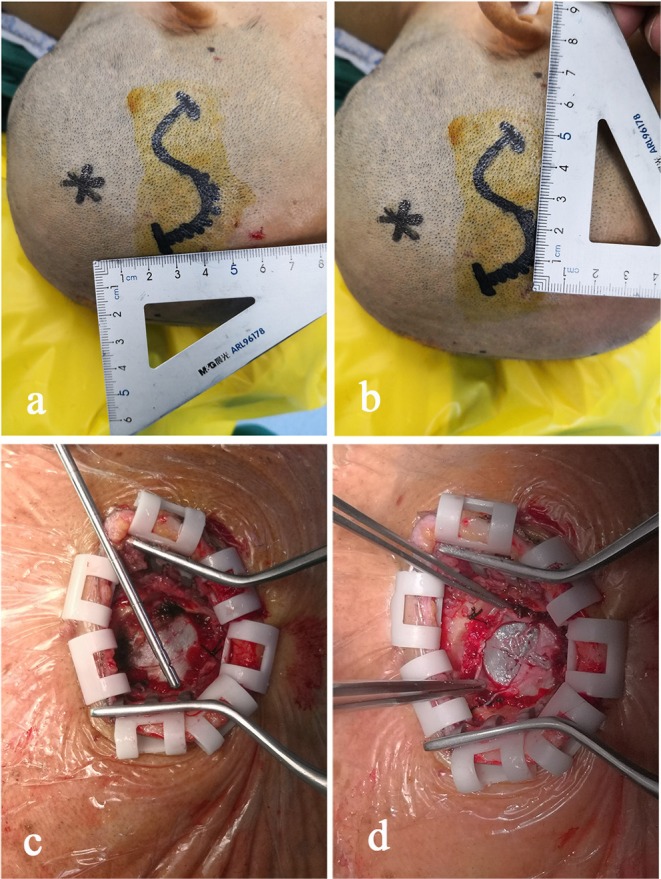
The midpoint of the surgical incision is generally 3–4 cm in front of the apical nodule. The direction of the incision is parallel to the scalp vessel, and the incision is in an “S” shape with a length of 4–5 cm (a,b). After a hole is drilled in the skull, a small bone flap with a diameter of 2.0–3.0 cm is cut using a milling cutter (c). The wall envelop of the hematoma sac can be seen using a cross-shaped incision after lifting the dura mater (d).